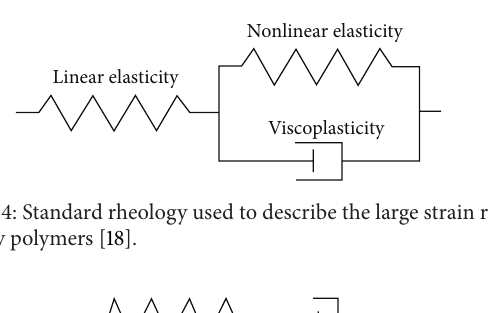
Figure 5: Arruda-Boyce model without the strain hardening ele- ment.